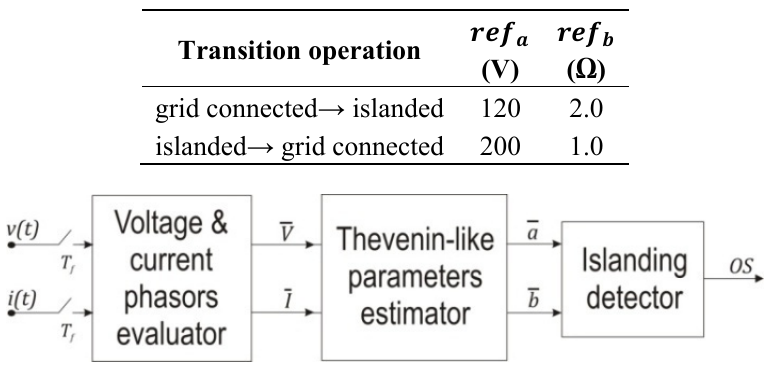
Table 3. SmartID thresholds.